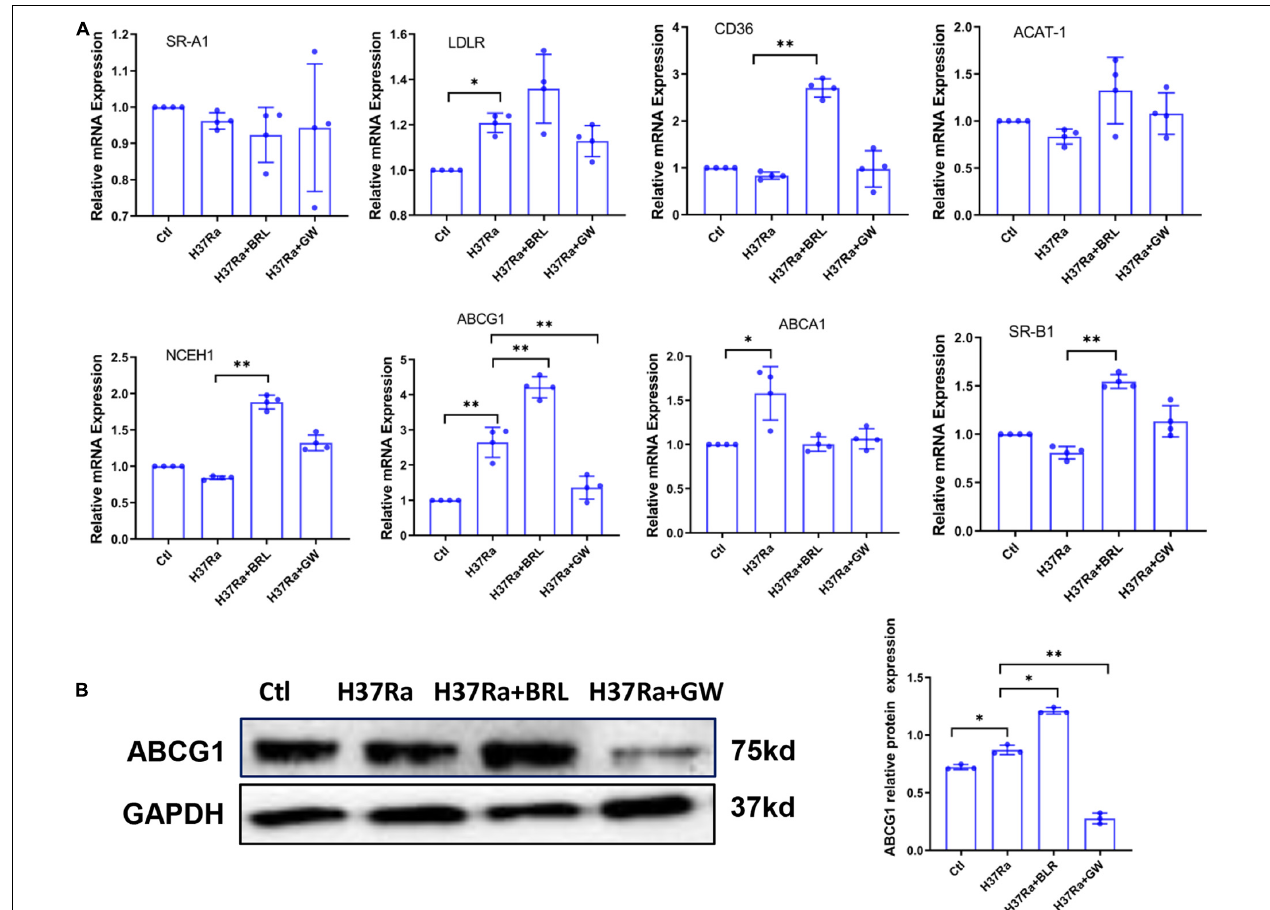
FIGURE 2 | Effect of peroxisome proliferator activated receptor γ (PPAR γ ) activity on the expression of lipid metabolism-related molecules. THP-1 cells were pretreated with BRL49653 (5 µ M) or GW9662 (1 µ M) for 30 min followed by infection with H37Ra (MOI = 10:1) for 24 h. The mRNA levels of SR-A1, LDLR, CD36, ACAT-1, NCEH1, ABCA1, ABCG1, and SR-B1 were detected by RT–PCR (A) . The protein expression of ABCG1 was determined by western blot (B) and quantified by grayscale scanning with ImageJ software. Data are expressed as the means ± SD of at least three independent experiments, ∗ P < 0.05, ∗∗ P <